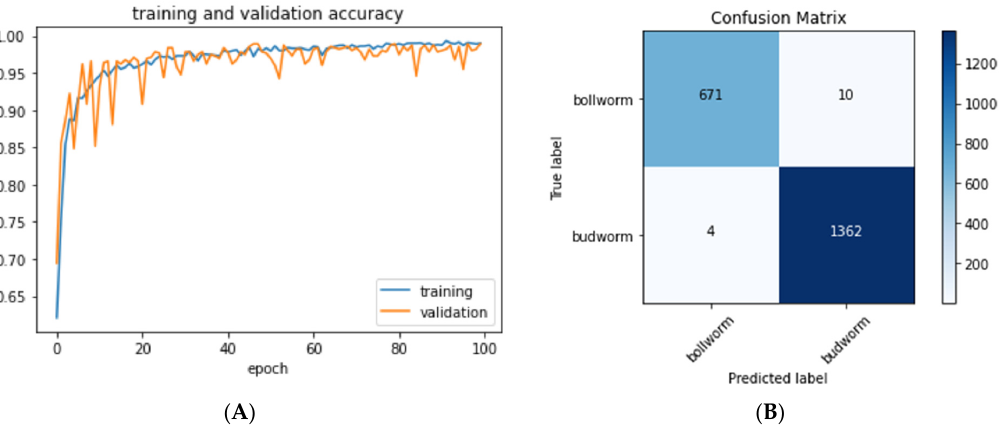
Figure 4. ( A ) Accuracy of the classification model over 100 epochs of training. Validation accuracy was chosen as the metric for optimization, and so models were saved when it increased. ( B ) Confusion matrix representing model accuracy results classifying our test dataset of 2047 egg images on black cloth with 99.3% accuracy. When the Predicted label matches the True label, counts lie on the diagonal from top left to bottom right indicating successful inference. Figure 1 depicts the initial Canon DSLR photographs on white versus black back- grounds to validate the morphological differences between Chloridea virescens and Heli- coverpa zea ; the morphological differences were originally described with line drawings by Neunzig [15]. Differences are predominantly in the micropyle region of the egg (Figure 1, MP) where the primary ribs (Figure 1, PR) end before touching the rosette (R) in C. virescens forming a “gap” (G). In H. zea the primary ribs continue to the rosette. Addition- ally, there are cross ribs (Figure 1, CR) present in H. zea that are absent in C. virescens , and in C. virescens , there are small points (P) present on the egg surface that are absent in H. zea . Our photos confirmed the previously reported egg morphology of C. virescens and H. zea . An example of the image-processing pipeline is shown in Figure 2. Each image cap- tured from the MCAM™ was passed through the preprocessing steps as described previ- ously to extract in-focus images of caterpillar eggs. A total of 5502 images of eggs were acquired, extracted, and organized with 3455 images in the training set and 2047 in the test set. A subset of the training data was further partitioned for use as a validation set. Final image counts are shown in Table 1, considering the distribution of both training, validation, and test sets for the two species of caterpillar eggs. Table 1. The number of image samples in each subset of the overall dataset. Dataset Image Count